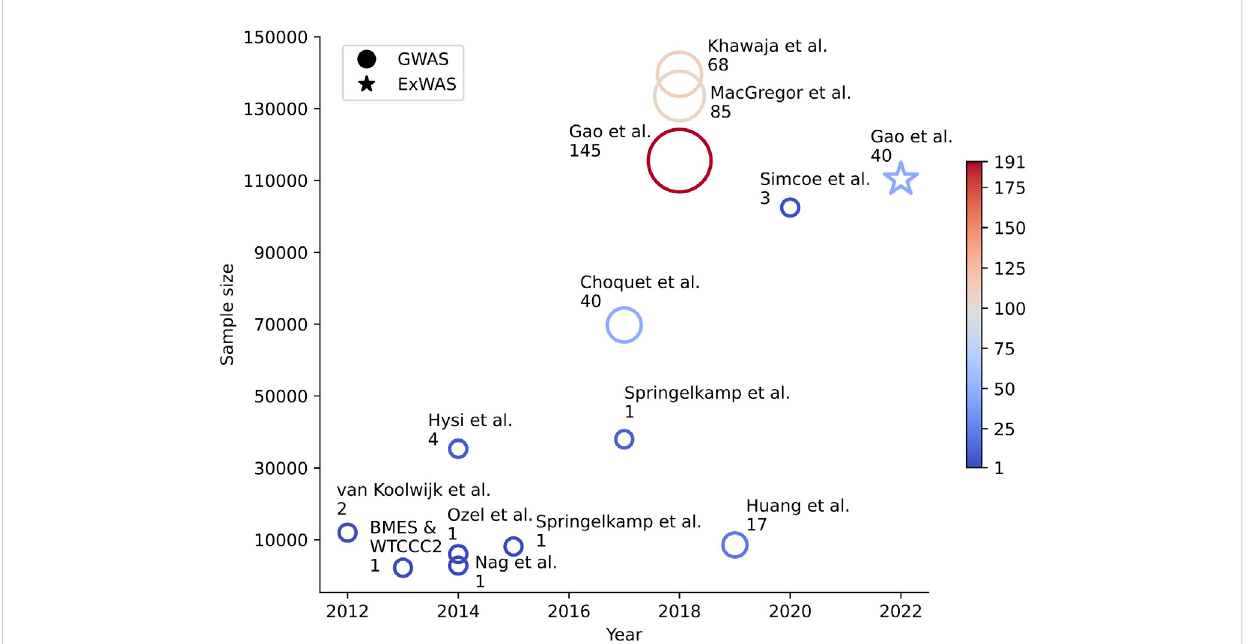
FIGURE 1 Number of novel intraocular pressure loci and study sample size in the last 10 years. Genetic association studies for IOP published in the past 10 yearsarerepresentedbyeither(a)acircleforGWASor(b)astarforExWAS.Thex-axisshowstheyearthestudywaspublished,andthey-axisshowsthe samplesizeofthestudy.Thecolorandsizeofeachplottediconareproportionaltothetotalnumberoflociandthenumberofnovellocidiscoveriesthat were reported in the corresponding study,